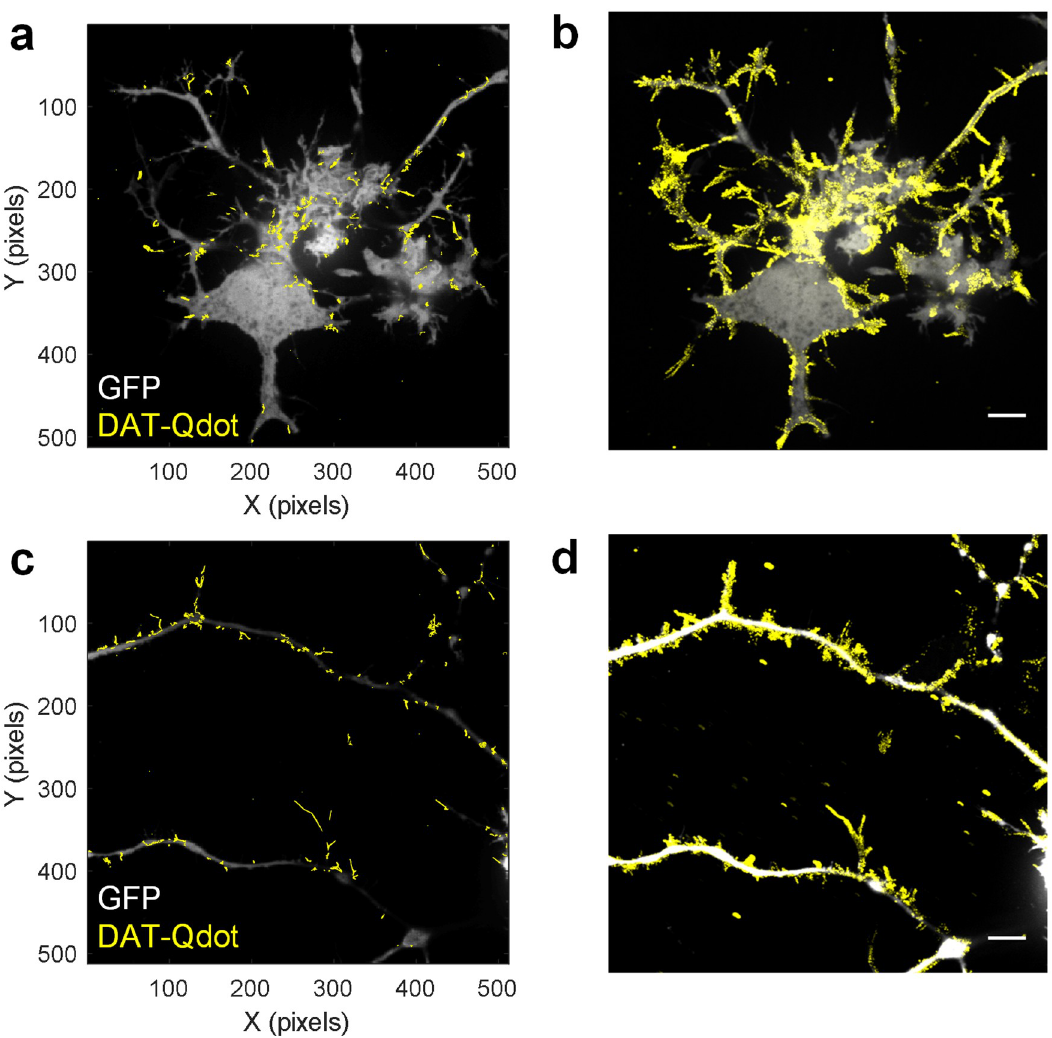
Fig 3. Avoidance of flat membrane regions by diffusing DAT-Qdots in N2A cells. Panels in a and c show DAT-Qdot motion over 60 s acquired at 10 Hz in GFP-expressing N2A cells. Maximum intensity projections in b and d show DAT-Qdot localizations acquired over 30 min at 0.1 Hz in GFP-expressing N2A cells. Scale bar:10 μ m. Images are representative of 3 independent experiments. Two MatTek dishes plated per passage with three to six 512x512 fields of view acquired per MatTek dish constituted an independent